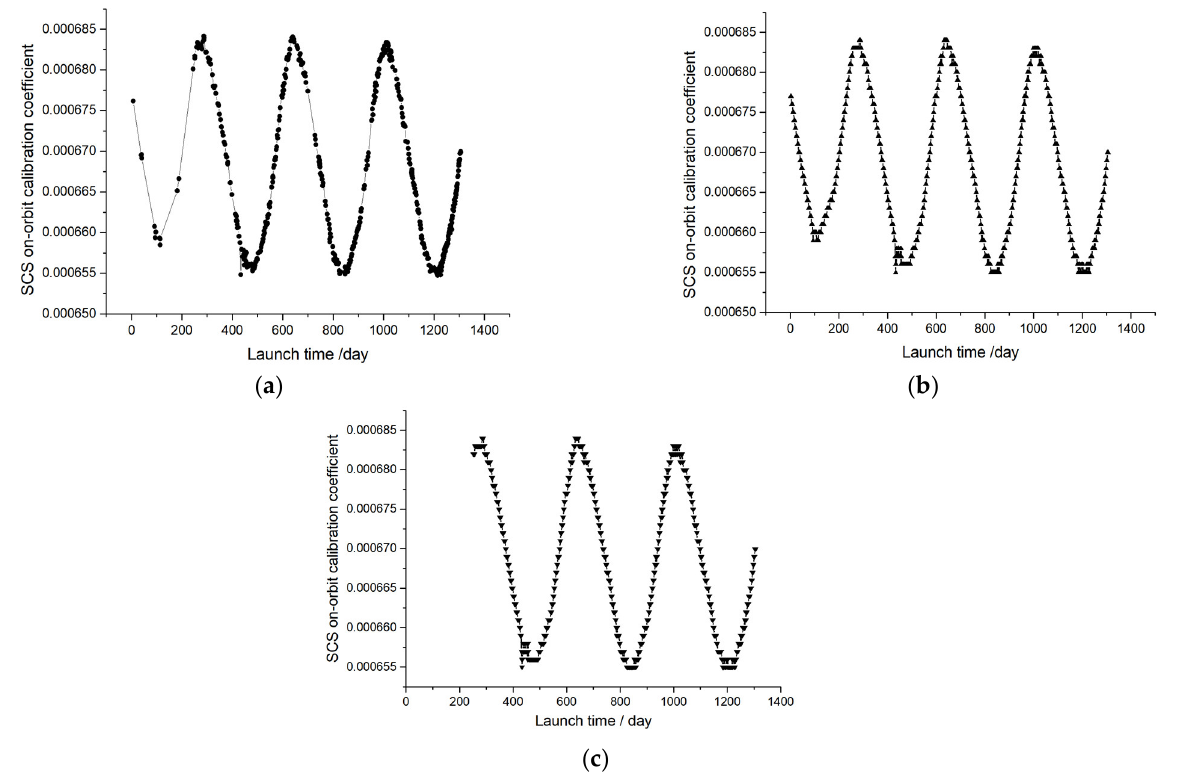
Figure 6. Long-term calibration coefficient of one spectral band of SCS from 8 September 2018 to 7 April 2022. ( a ) Original calibration coefficient; ( b ) processed calibration coefficient time series; ( c ) calibration coefficient without data from first 250 days.